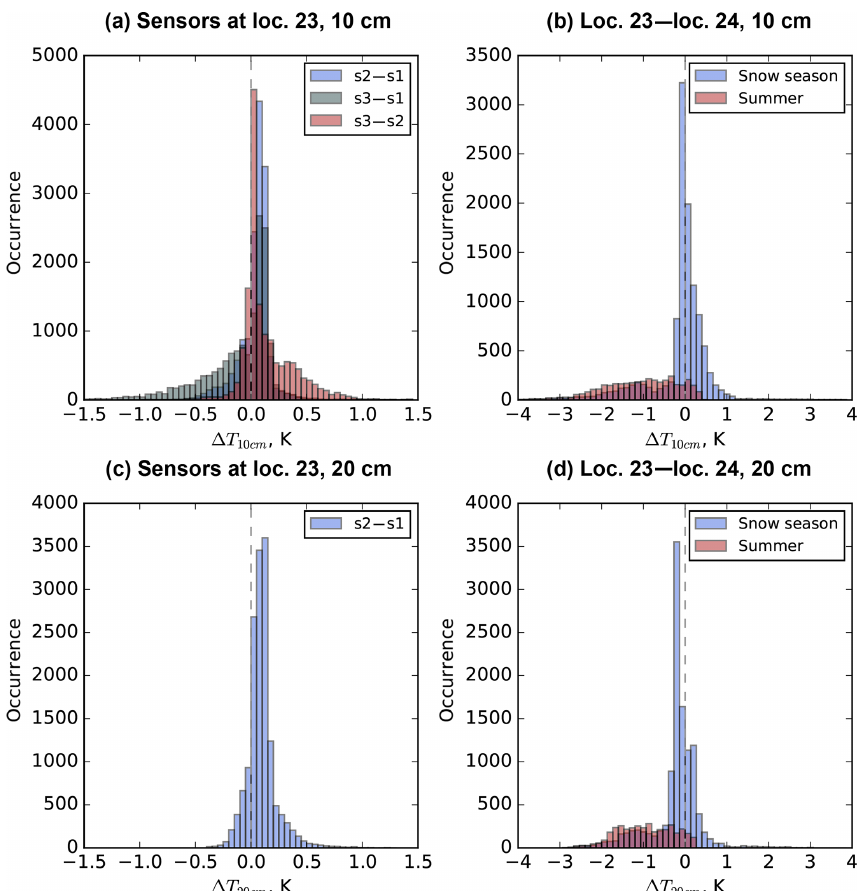
Figure 10. Comparison between the different soil temperature measurements at 10cm (a, b) and 20cm (c, d) depths. Panels (a) and (c) com- pare the new sensors (three probes) at location 23 (Fig. 2) at 10cm underground and two probes at 20cm underground. Panels b and d compare the average values of the new sensors (location 23, Fig. 2) to the old ones (location 24, Fig. 2). Statistics are calculated from December 2015 to July 2017. Summer ( b and d , in red) corresponds to the periods between 20 June 2016 and 10 October 2016 as well as 20 June 2017 and 31 July 2017. The rest of the dates correspond to the snow season ( b and d , in blue). Numerical values are provided in